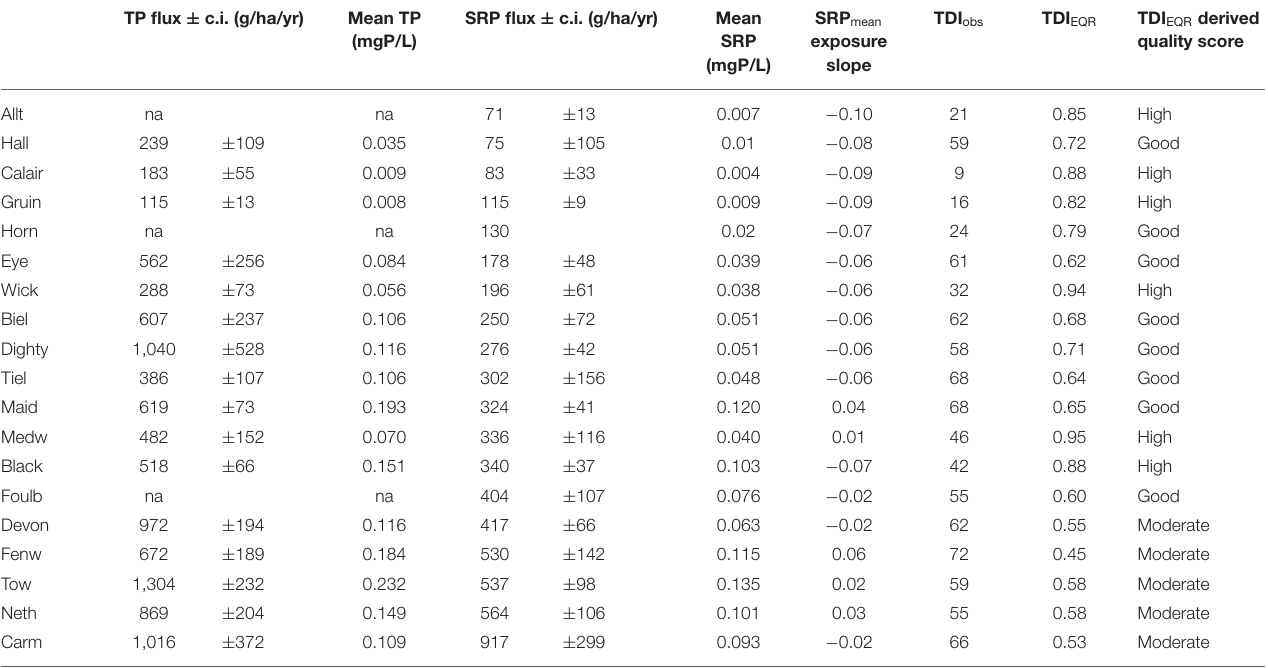
TABLE 6 | Summary water chemistry and ecology data for sites ordered from lowest to highest SRP flux.